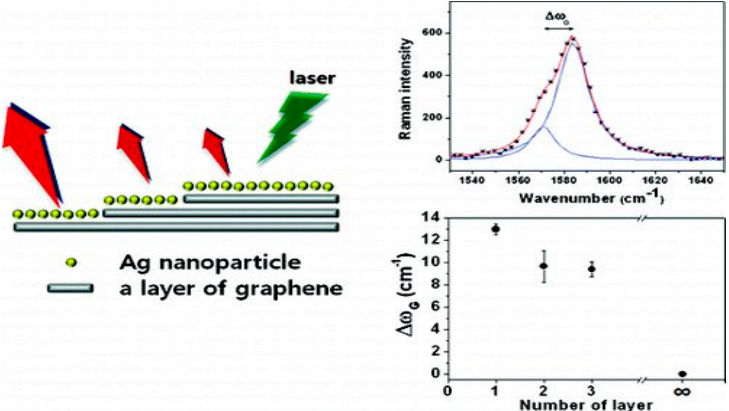
Figure 4. Laser deposition of metal on three different graphene layers and dependence of the order of G-band splitting on the number of graphene layers (Reprinted (adapted) with permission from [17] Copyright © 2011, American Chemical Society).